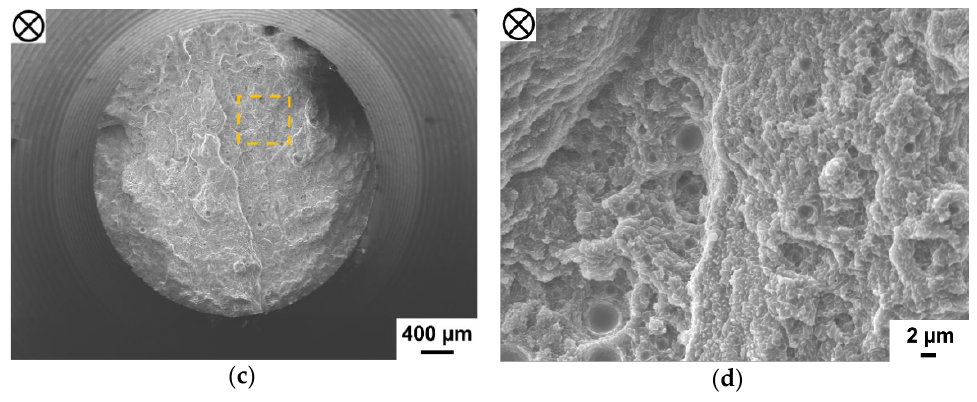
Figure 5. Fracture surfaces of ( a , b ) horizontally (X) and ( c , d ) vertically (Z) oriented samples ( a , c : SEM, x50, 15 kV, 35 mm, 80 pA, SE; b , d : SEM, x5000, 15 kV, 15.5 and 11.5 mm, 80 pA, SE). Building direction is presented by a black arrow or by a cross inscribed in a circle. Highest magnifications ( c , d ) were shot from framed areas.